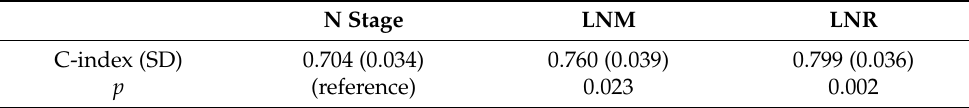
Table 2. Comparison of N stage, LNM, and LNR.